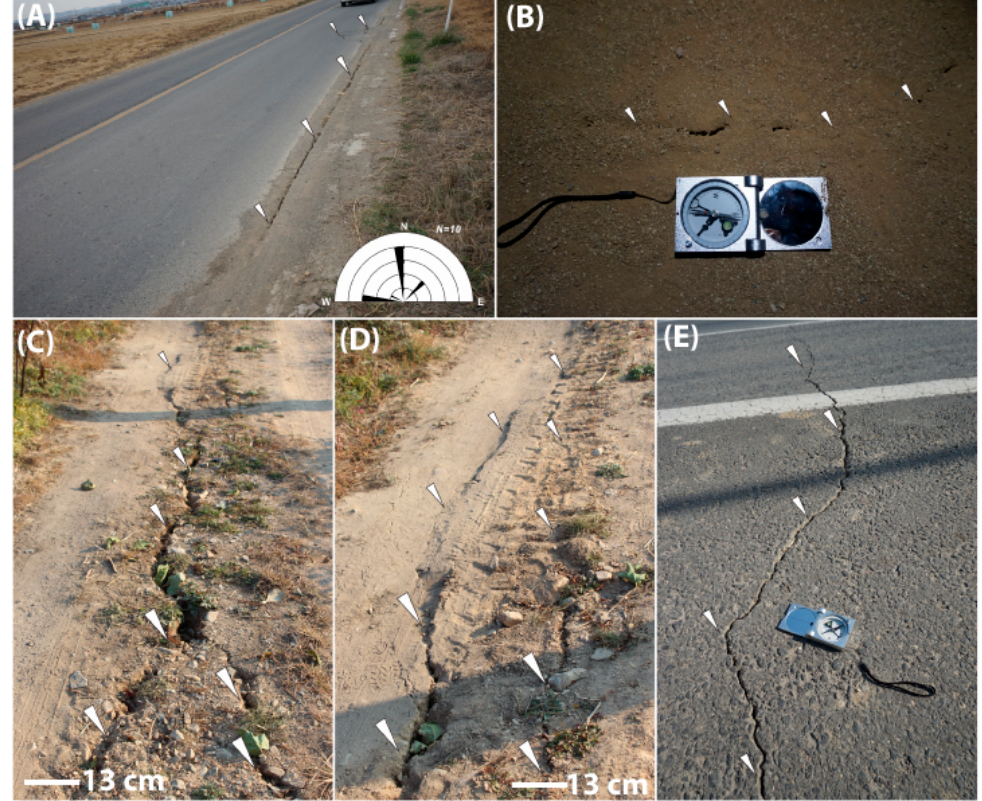
Figure 7. Field photographs showing ( A ) The cracks on a paved road due to di ff erential settlement; ( B – D ).GroundcracksandlateralspreadingalongthecanalembankmentsduringthePohangearthquake. Most of the cracks showed the N-S trend; ( E ) En-echelon cracks along a paved